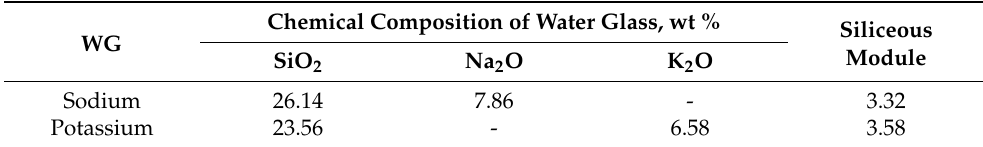
Table 1. Characteristics of sodium and potassium water glasses. Chemical Composition of Water Glass, wt % Siliceous WG ModuleSiO 2 Na 2 O K 2 O Sodium 26.14 7.86 - 3.32 Potassium 23.56 - 6.58